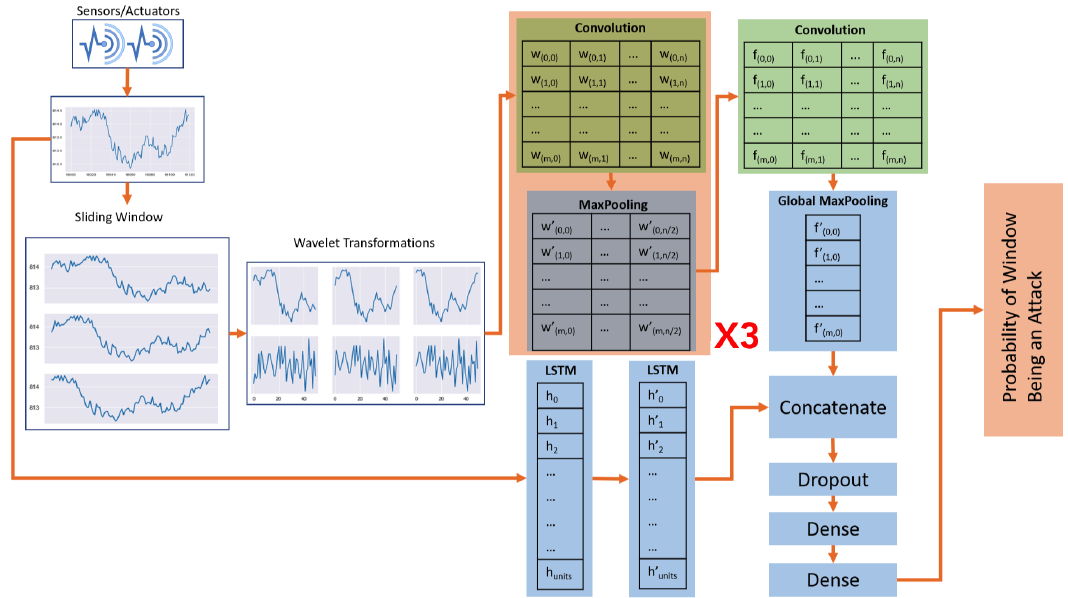
Figure 3. Classification model using convolutions, LSTM, and dense layers. Here, w, w’, h, h’, f, and f’ represents the intermediate